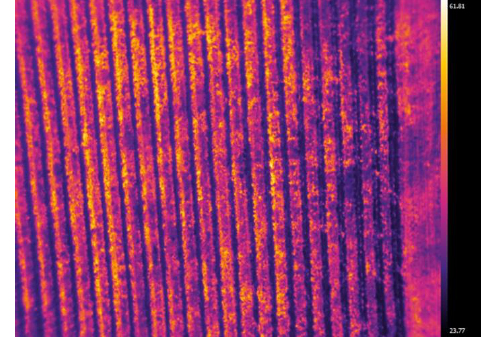
Figure 10. NDVI values 2015 –